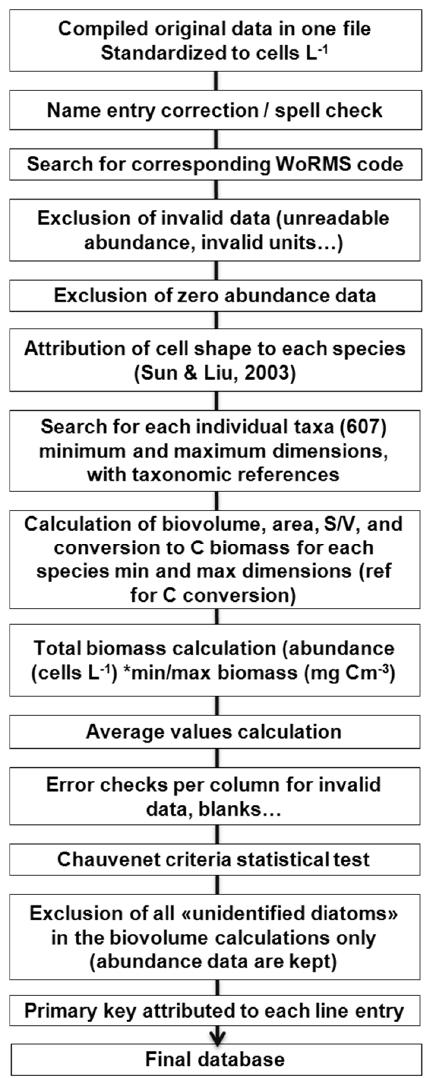
Figure 1. Flow diagram of the methodology used to derive diatom biomass estimates from abundance